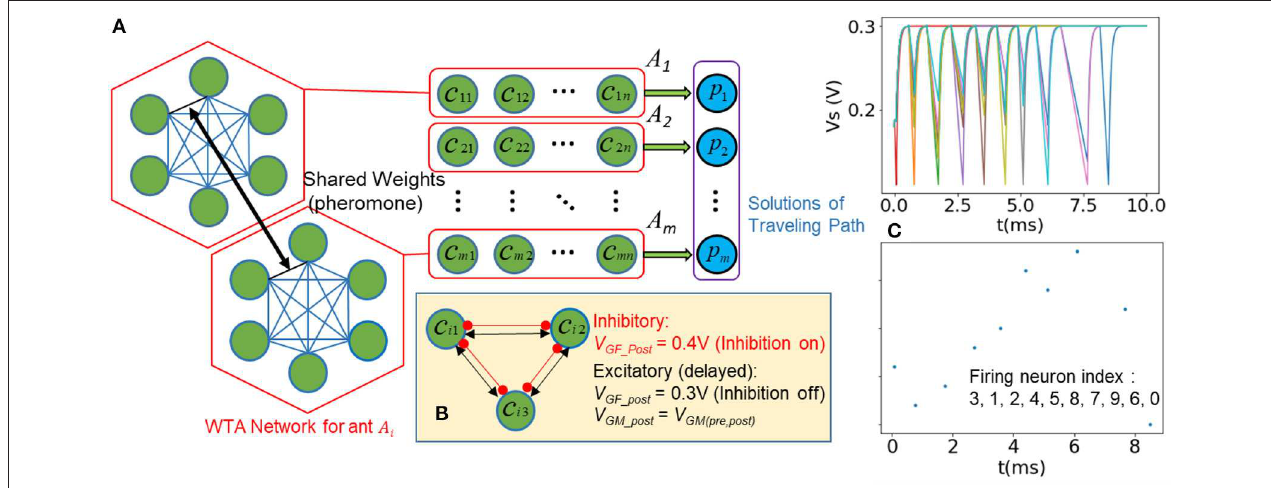
FIGURE 5 | (A) Modified SI-SNN architecture for solving TSP (B) inhibitory and excitatory synapses enable that only one neuron fires after latest pre-synaptic spike in a WTA network (C) Plot of state variable Vs and the raster plot that shows the order of fired spikes in one trip.